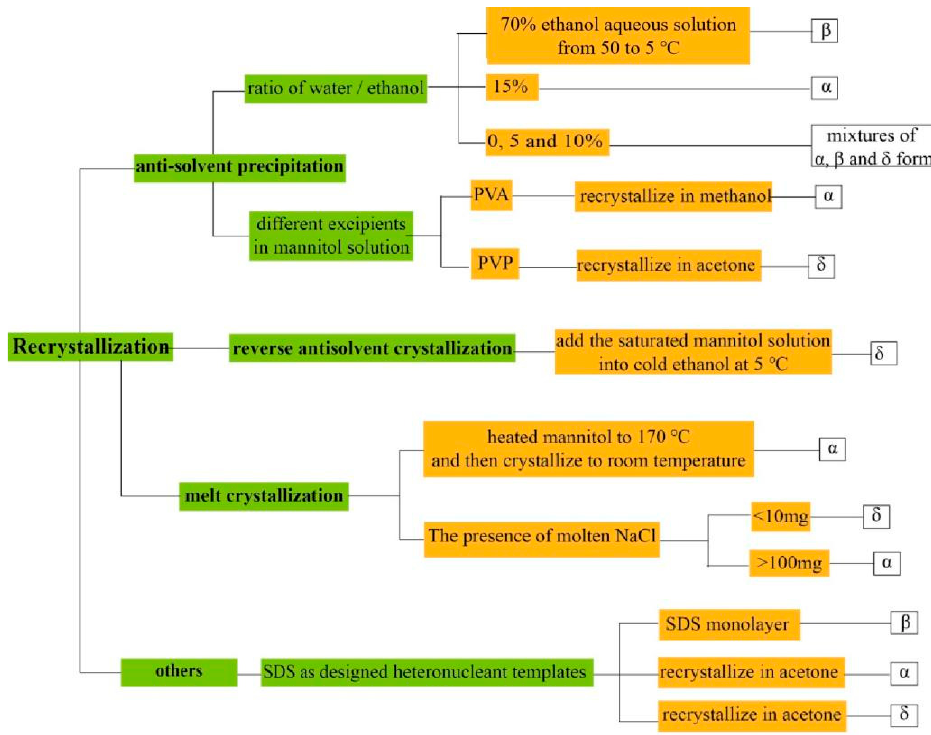
Figure 8. Schematic of recrystallization method for the preparation of polymorphic mannitol.